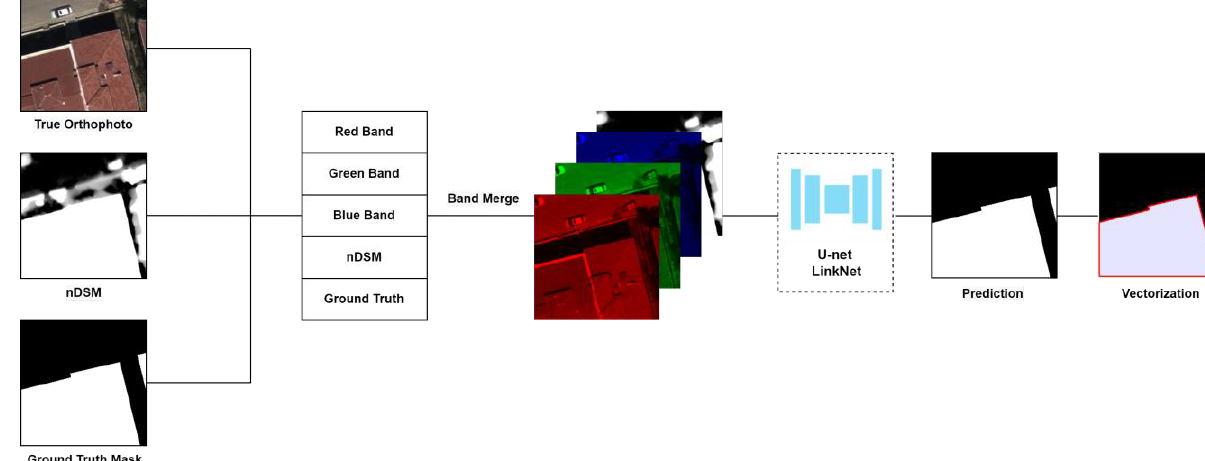
Figure 3. An overview of the workflow for building extraction and vectorization with the help of DL